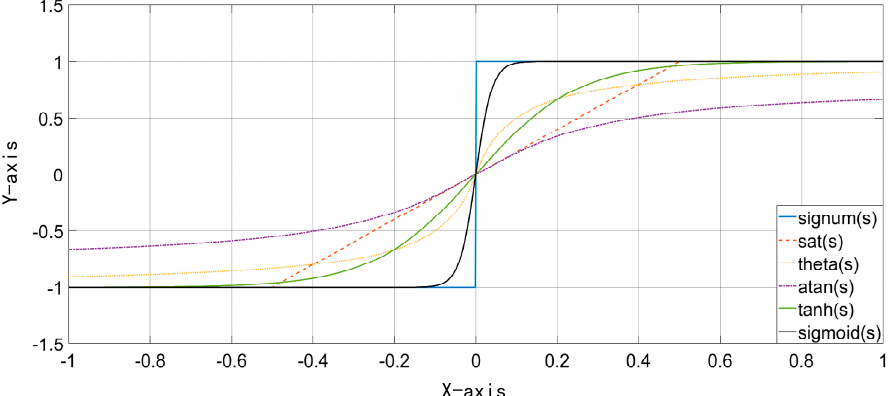
Figure 5. Comparison of curves of different functions.